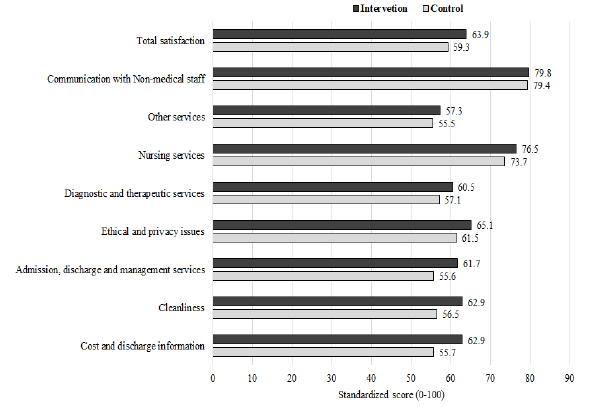
Figure 2. Satisfaction score in the intervention (patients with ENC) and control groups (patients without ENC) by domain and total